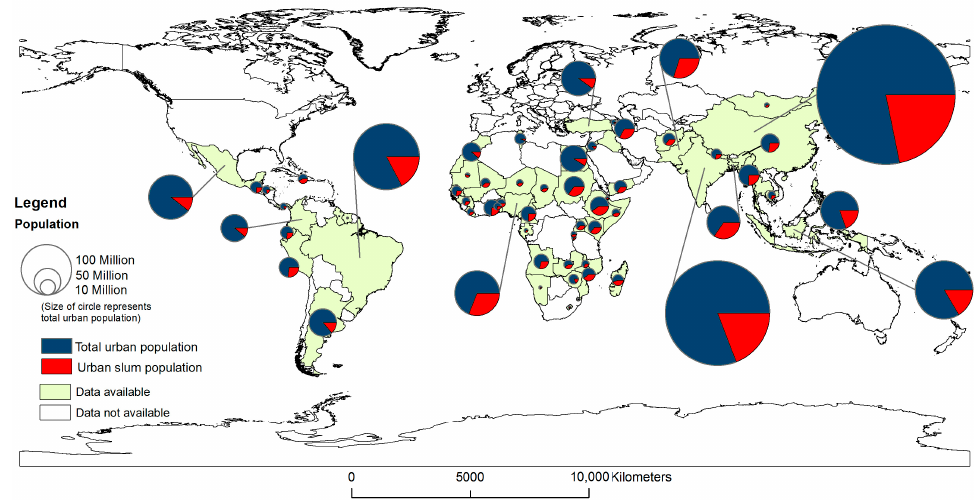
Figure 3. Global distribution of urban and slum populations (Data—Urban Population estimates